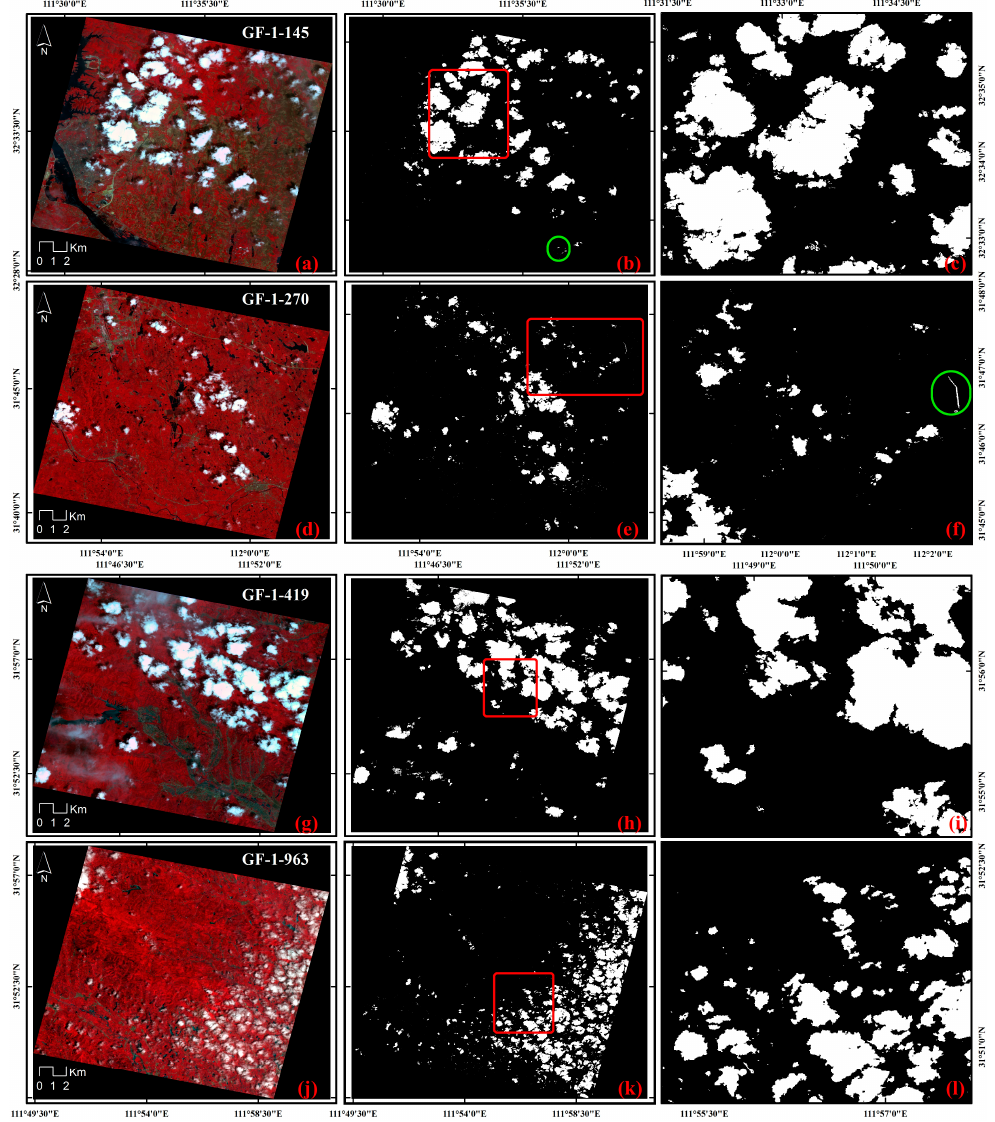
Figure 5. The original map and classification results of four selected GF-1 images: ( a – c ) the original map, cloud classification map, and the magnified area corresponds to the red line regions of cloud classification map for GF-1-145, respectively; ( d – f ) for GF-1-270; ( g – i ) for GF-1-419; ( j – l ) for GF-1-963.The white regions in the classification results represent our cloud detection results. The green frame refers to cloud detection misjudgments.